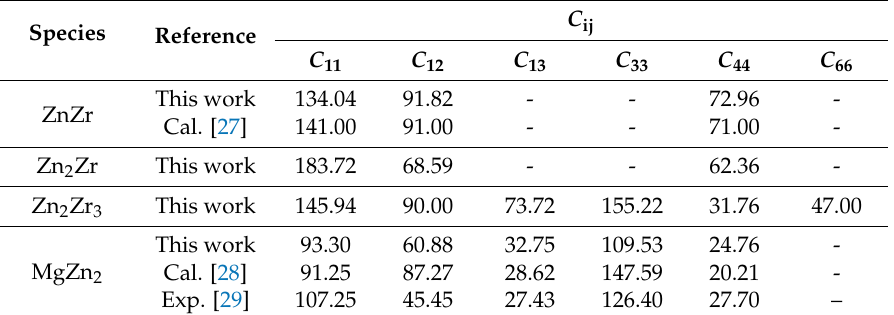
Table 2. The calculated independent elastic constants (GPa) of Zn-Zr intermetallic compounds and MgZn 2 using the strain-energy method with other calculated (Cal.) and experimental (Exp.) data.